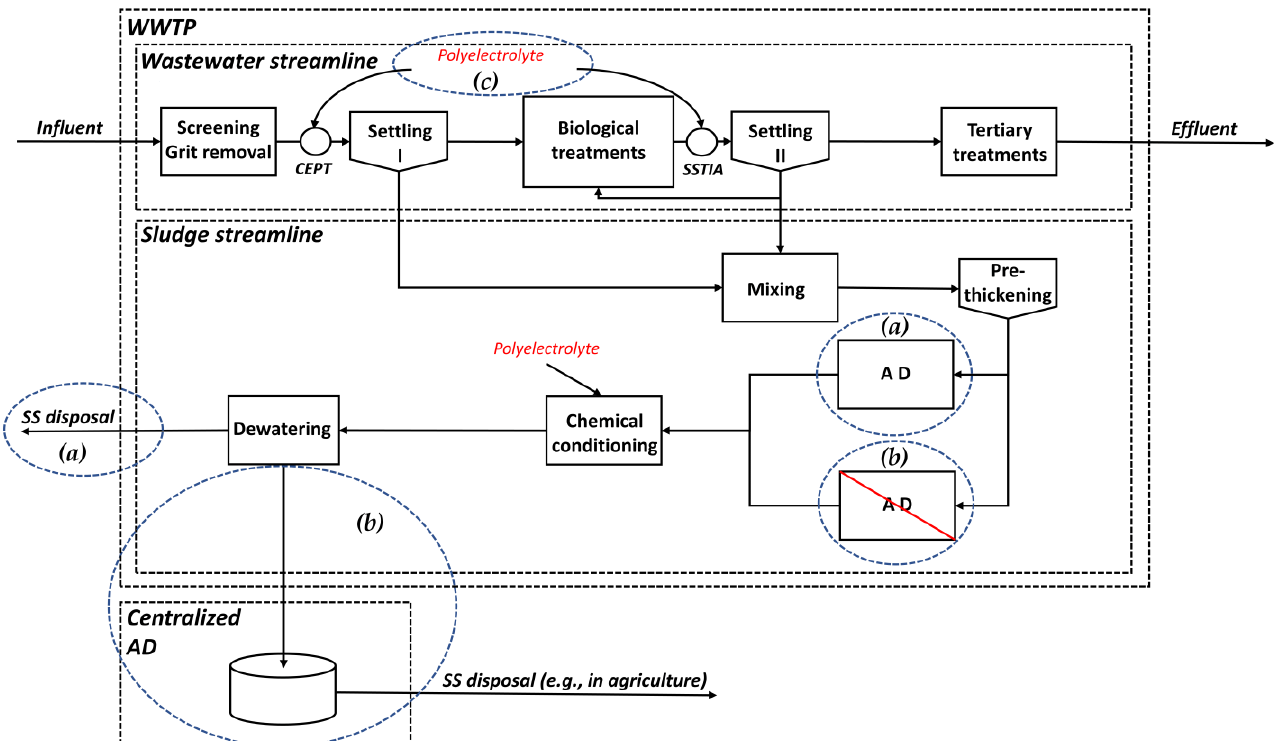
Figure 1. Potential routes for the anaerobic stabilization of sewage sludge pre- or post-conditioning: ( a ) AD is performed before conditioning, ( b ) AD of conditioned sewage sludge is performed in centralized plants outside the WWTP, ( c ) sludge conditioned in the mainstream settling phases undergoes AD within or outside the WWTP.